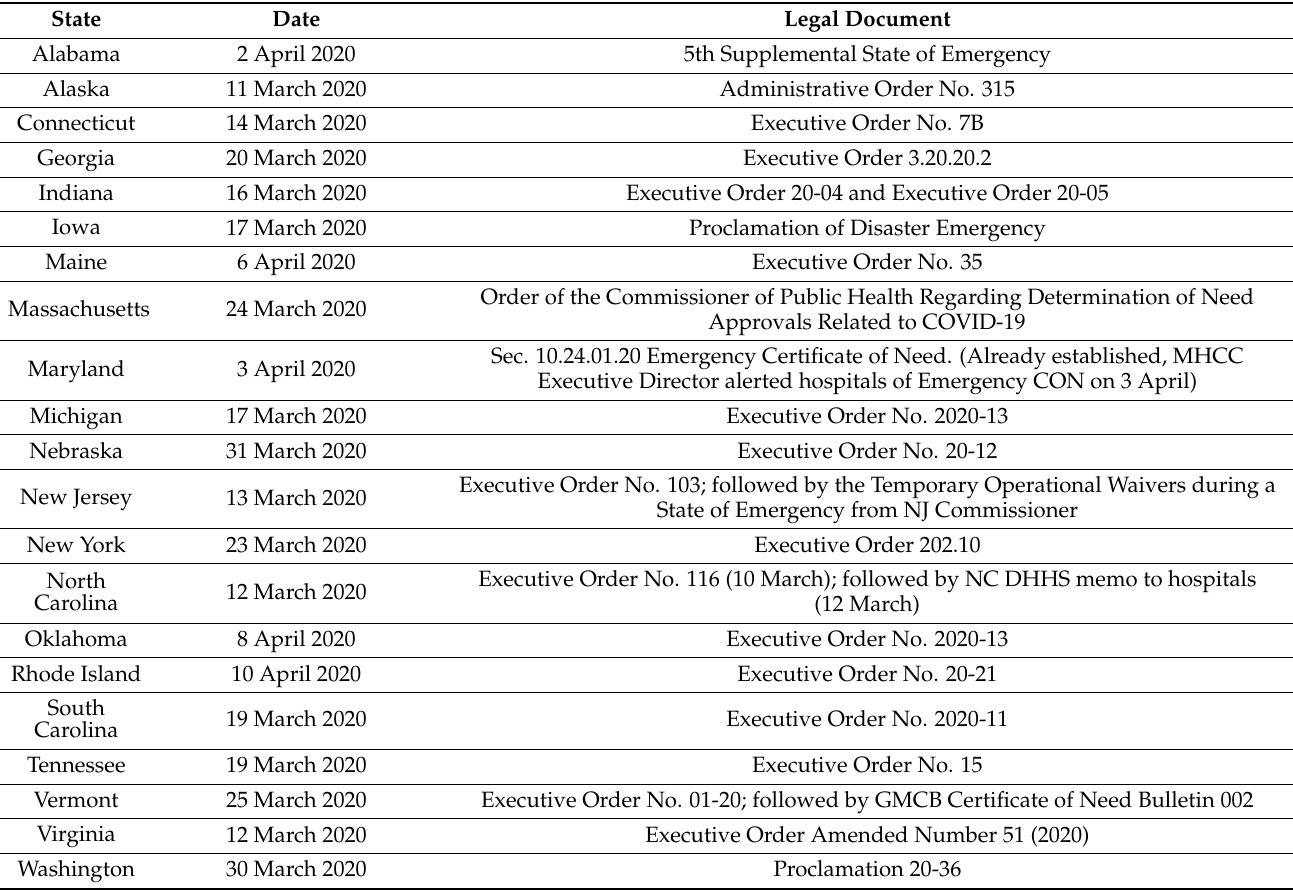
Figure 1. Map of CON Laws. Table 2. List of initial documents initiating CON law changes.